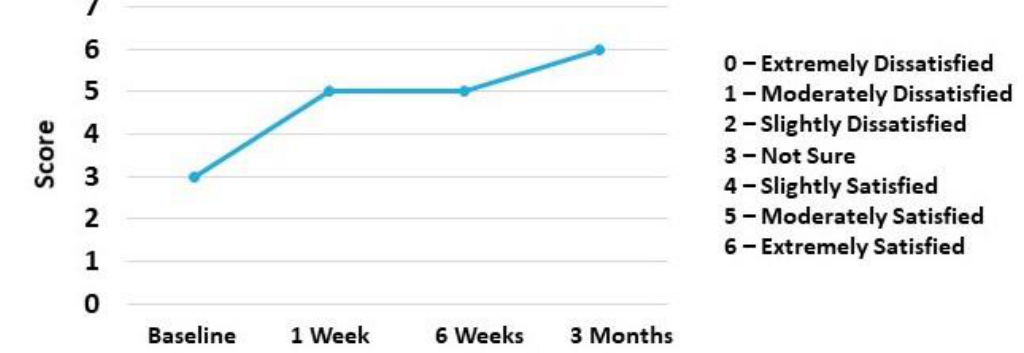
Figure 4. 7-point Likert Scale. Patient was “extremely satisfied” at end of 3 months compared to “not sure” at baseline.